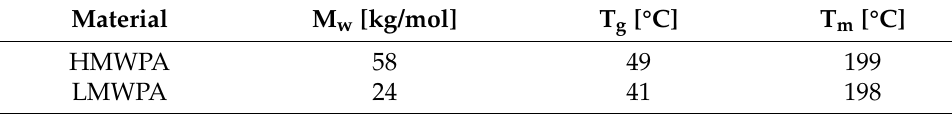
Table 1. Material properties of the PA 6/66